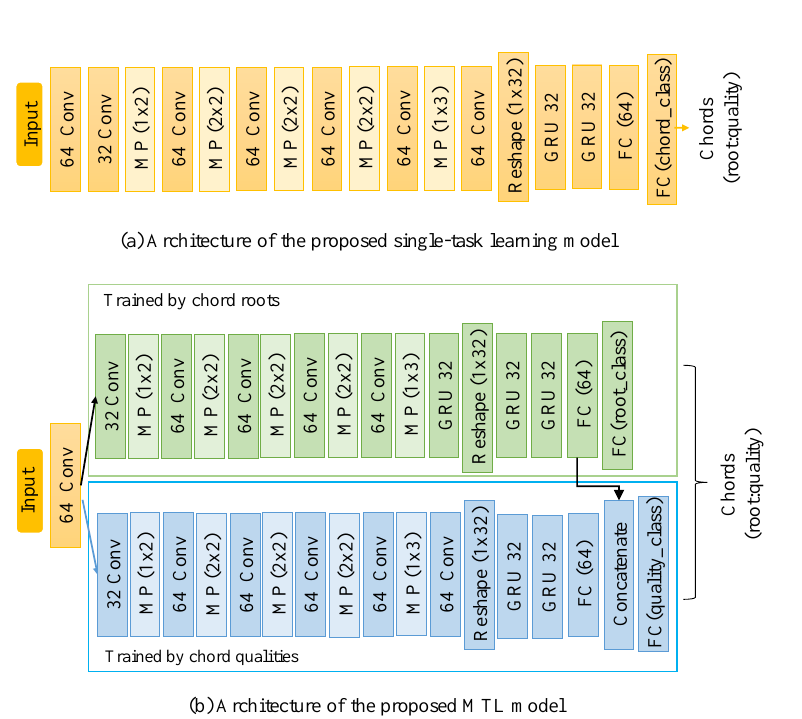
Figure 7. Architectures: ( a ) Single-task learning architecture that is identical to the sub-network of the multi-task learning architecture. ( b ) Multi-task learning model. The chord root and qualities are trained by specific networks from the same dataset, and the output is presented in the form of root:quality. Here, MP represents the max-pooling layer, and FC is a fully connected